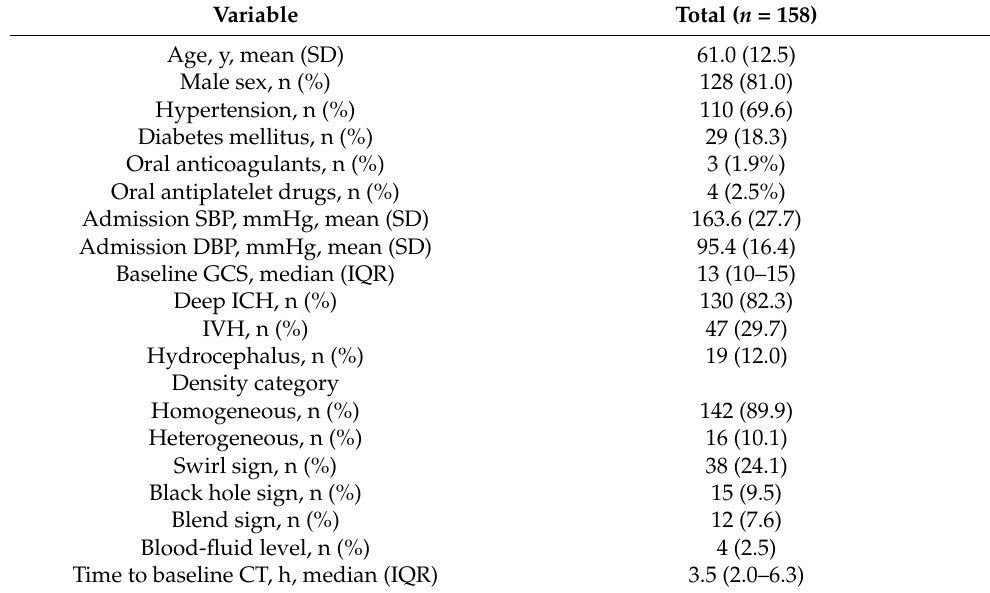
Table 1. Clinical and imaging characteristics of patients with intracerebral hemorrhage who were included in the